Question: Express in one sentence what the figure is showing.
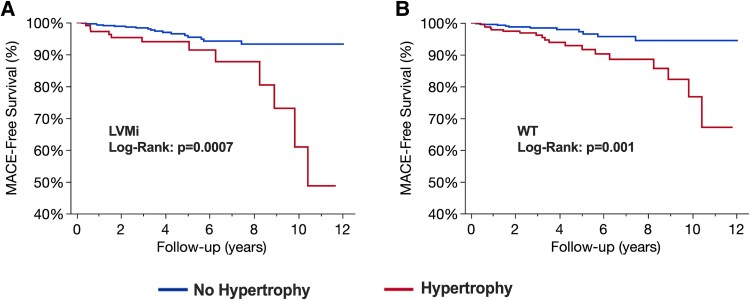
Answer: Kaplan–Meier survival analysis of left ventricular mass index (LVMi) ( A ) and interventricular septal wall thickness (WT) ( B ). Outcome was time to major adverse cardiac event (MACE) defined as a composite of acute heart failure or cardiovascular death. Patients with known heart failure and/or hypertrophic or infiltrative cardiomyopathy were excluded. Blue lines represent patients with low- or normal values and red lines represent left ventricular hypertrophy. Cut-offs were derived from the literature utilizing upper normal values from cardiovascular magnetic resonance imaging (LVMi) and echocardiography (WT). Sex-specific hypertrophy cut-offs were LVMi >65 g/m 2 (female) and >83 g/m 2 (male), and WT >10 mm (female) and >11 mm (male).